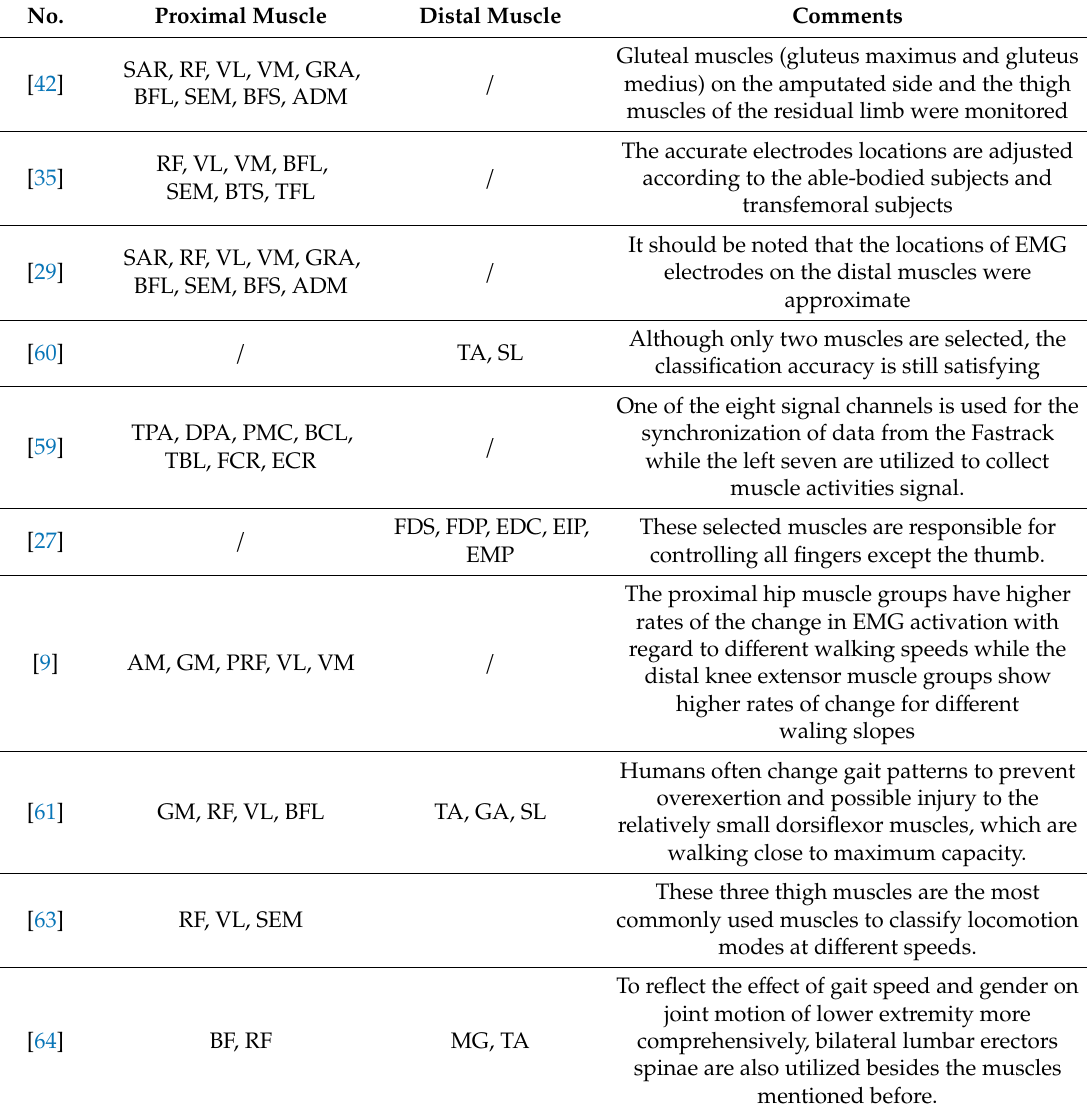
Table 1. Summary of the selected muscle group for detecting electromyography (EMG)